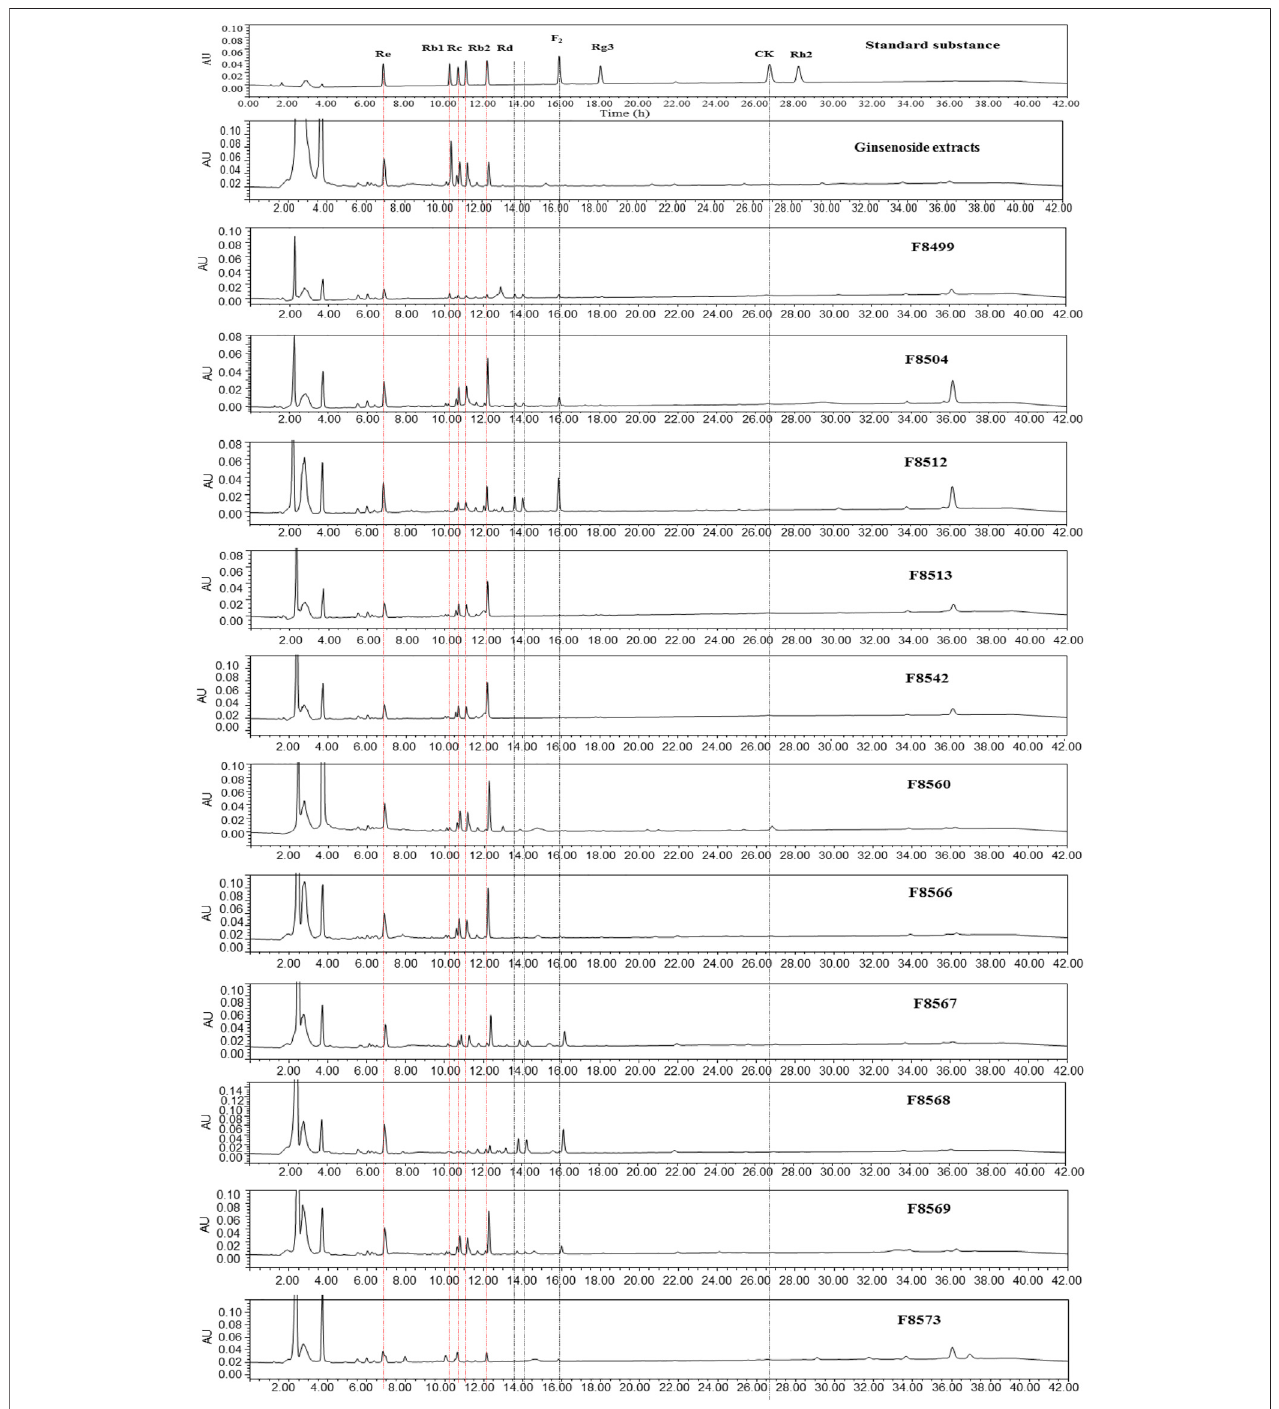
FIGURE 3 | HPLC spectra of the ginsenoside standards and ginsenoside biotransformation products by 11 strains with β -glucosidase activity.